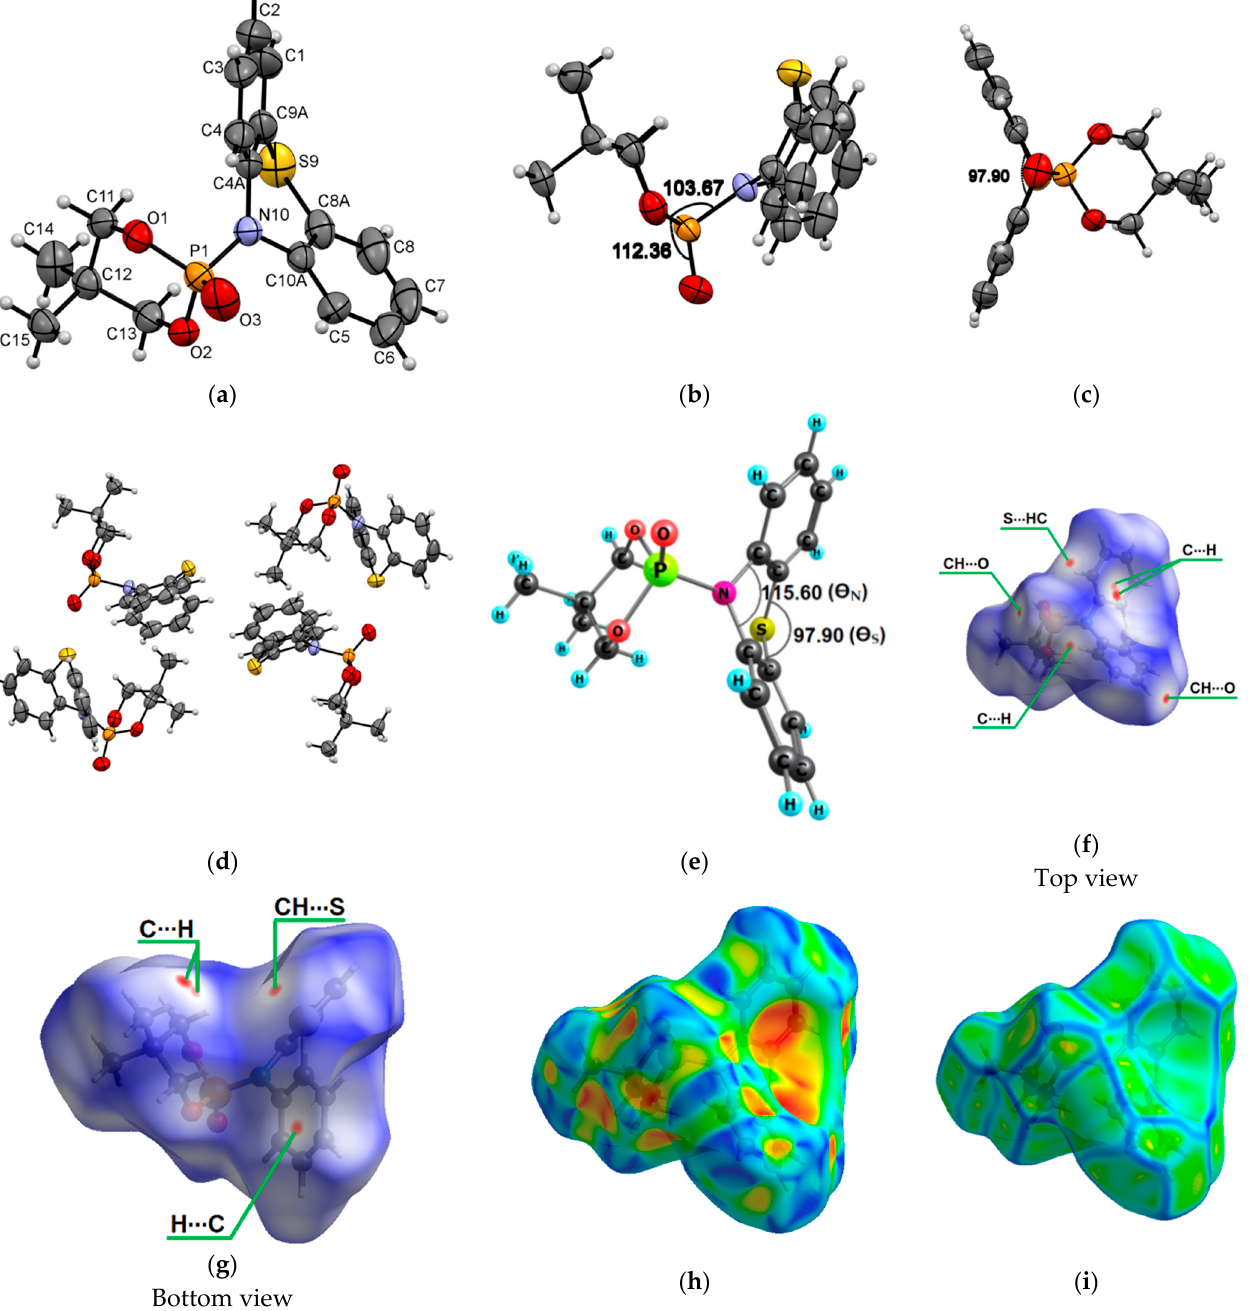
Figure 2. ORTEP drawings of 5,5-dimethyl-2-(10 H -phenothiazin-10-yl)-1,3,2-dioxaphosphinane 2-oxide ( 2a ) with 50% probability. Top view ( a ), angle view ( b , c ) and packing ( d ) [23]. Optimized structure of 2a with the bending angles in the middle phenothiazine ring marked ( e ). Hirshfeld surfaces for molecule 2a are mapped with d norm ( f , g ), shape index ( h ) and curvedness ( i ).